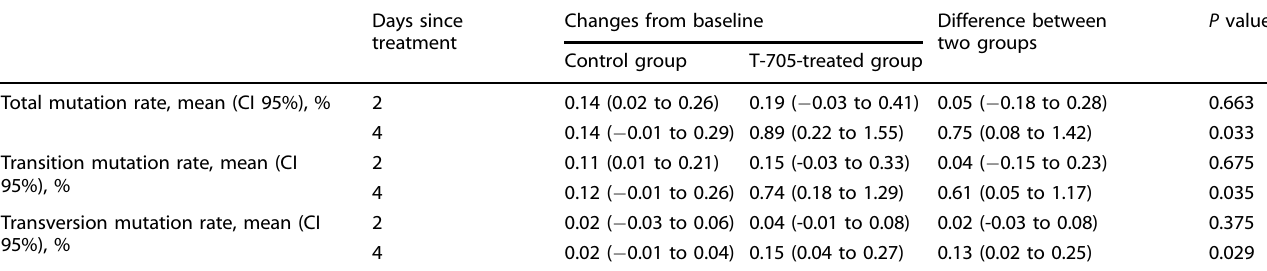
Table 2. Comparison of the changes of mutation rates from baseline between the T-705-treated group and the control group at days 2 and 4 since treatment